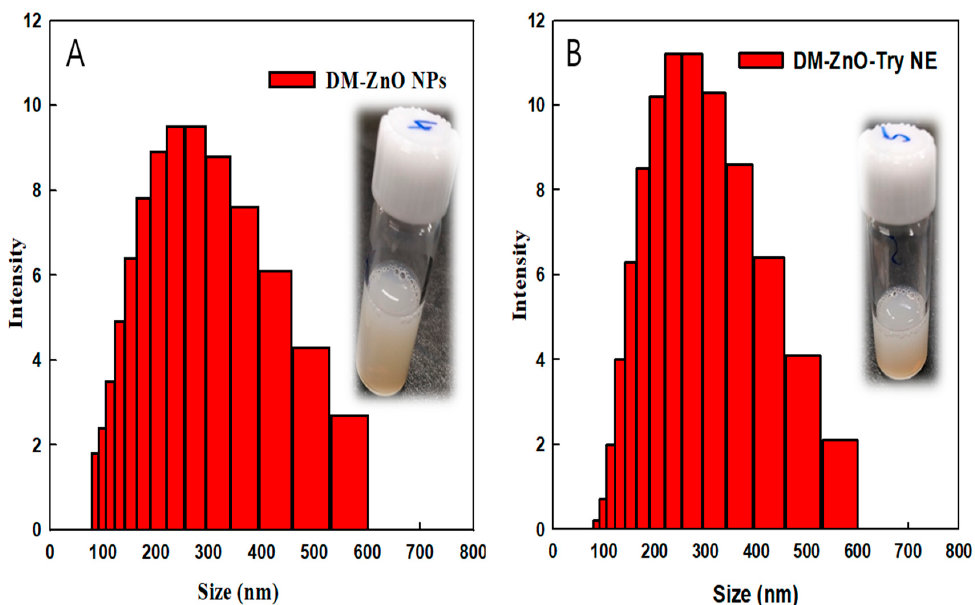
Figure 4. Size distribution analysis using the dynamic light scattering (DLS) analyzer for ( A ) DM-ZnO NPs and ( B ) DM-ZnO-Try NE.